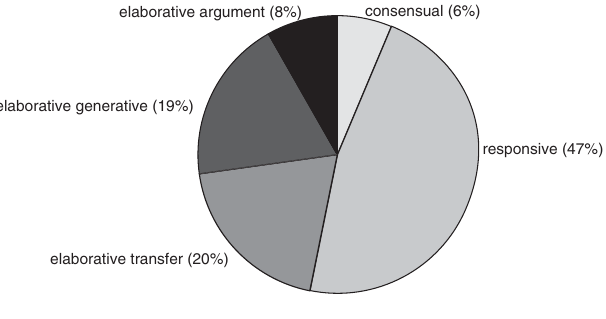
FIG. 4. Distribution of thread